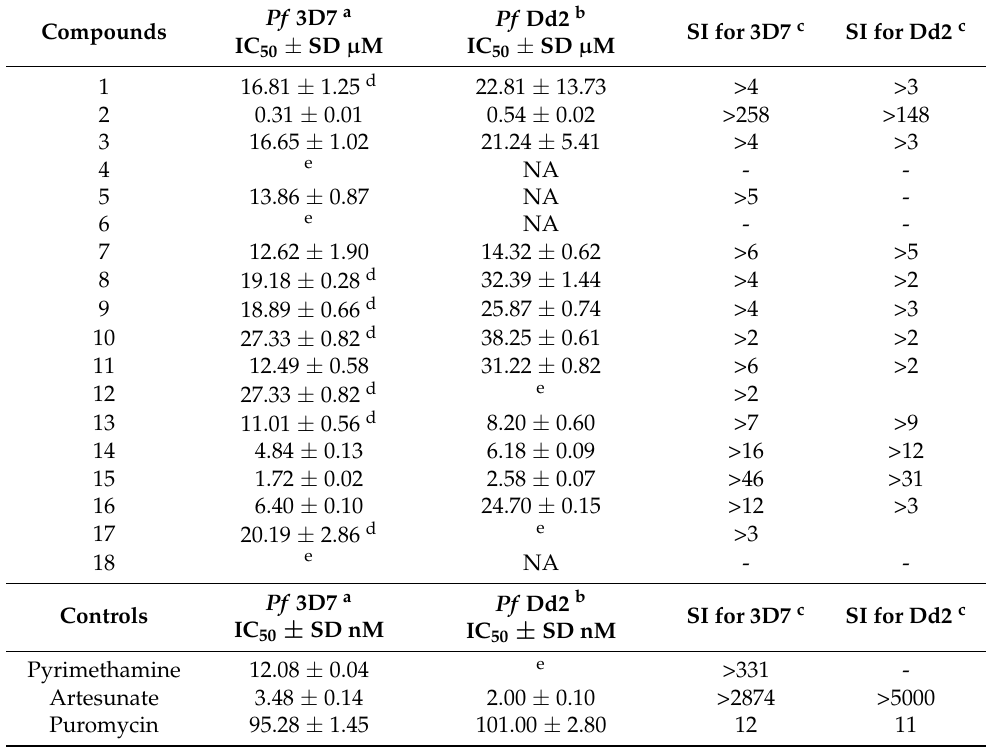
Table 3. Biological data for triazolopyrazines 1 – 18 .